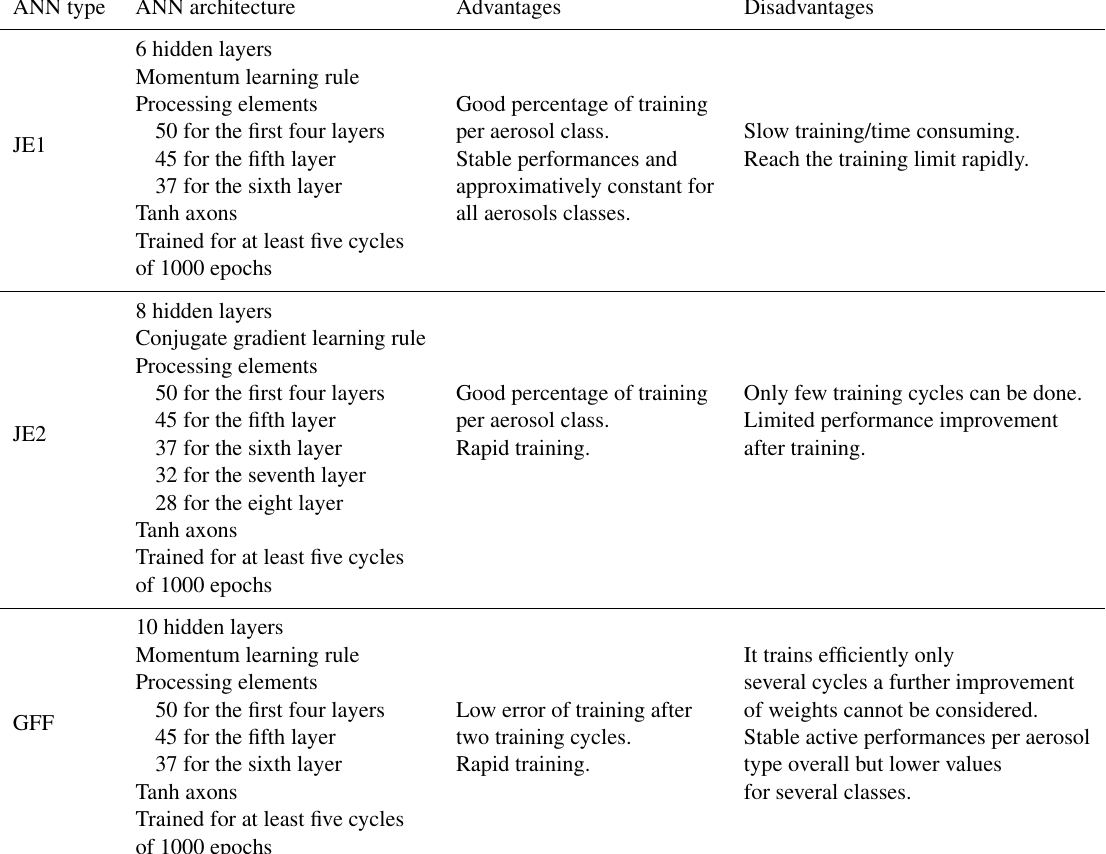
Table 3. Selected types of artificial neural networks and their structures. ANN type